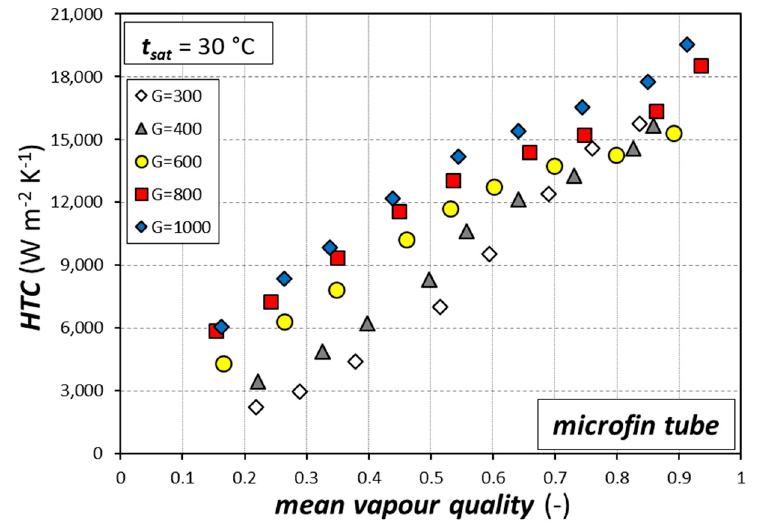
Figure 7. Heat transfer coefficient during condensation for the microfin tube vs. mean vapor quality at t sat = 30 °C. G expressed in [kg m − 2 s − 1 ].